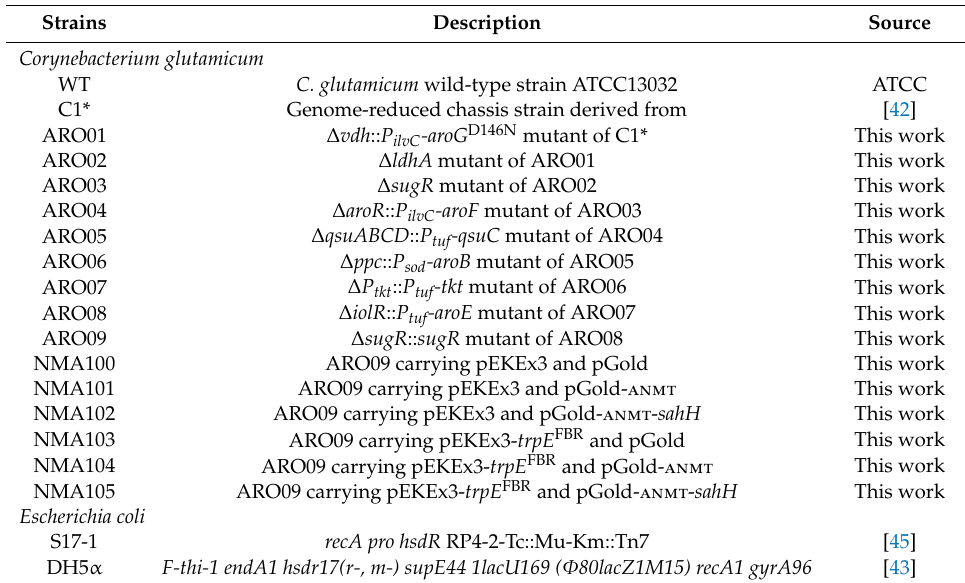
Table 1. Bacterial strains used in this